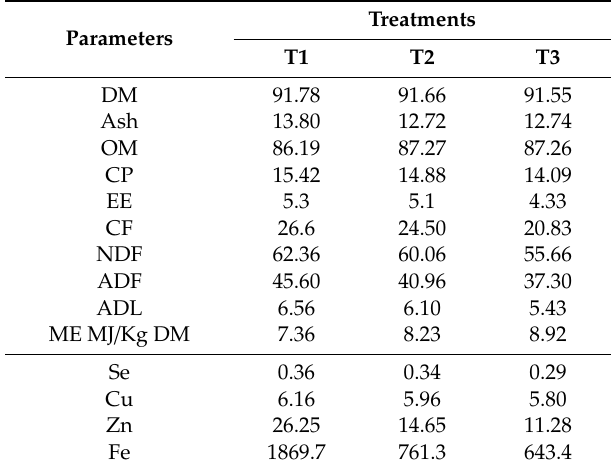
Table 1. Chemical composition and approximate analysis minerals (mg / kg dry matter (DM)) of experimental diets.